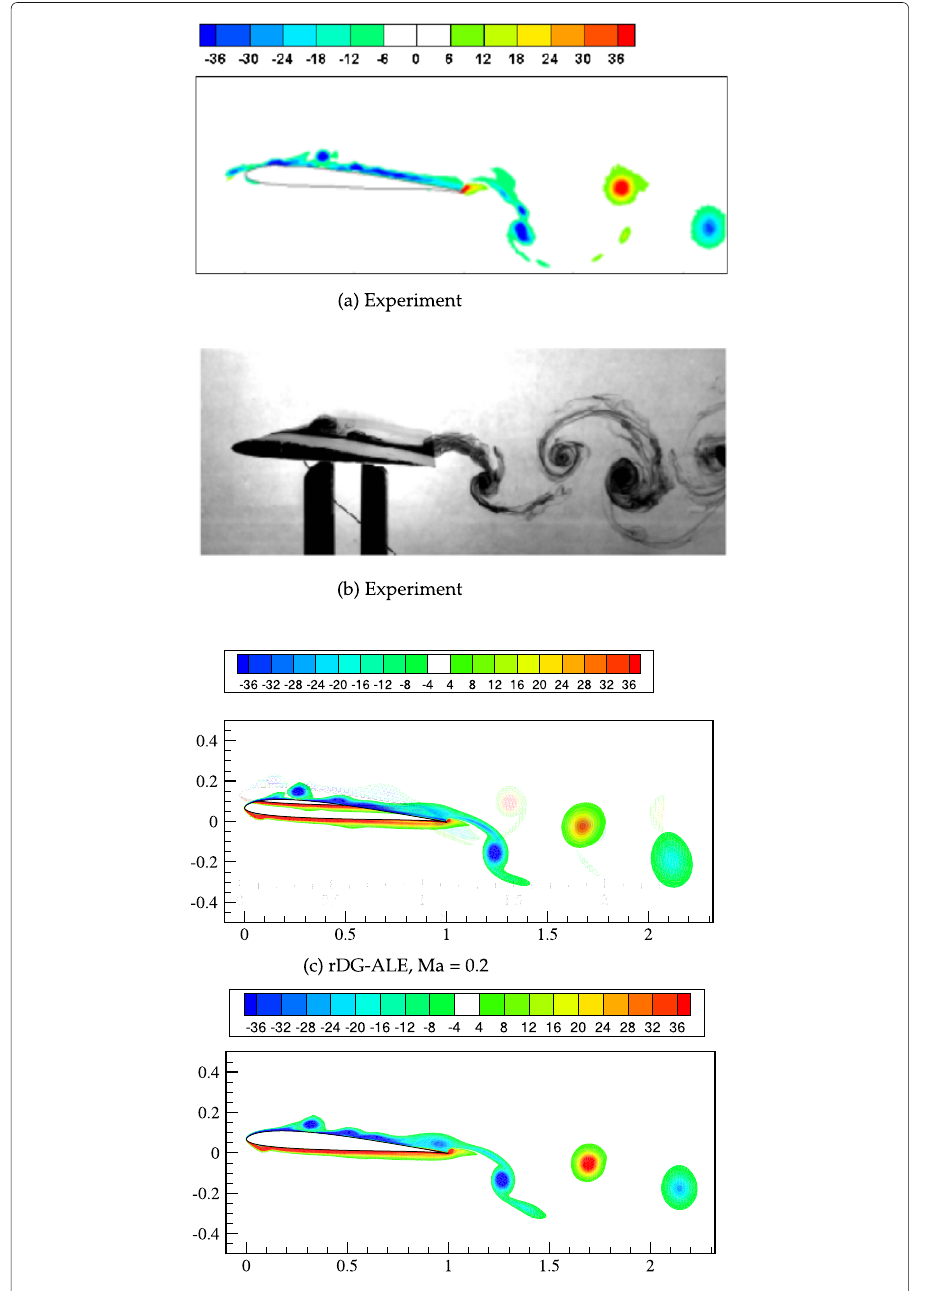
Fig. 18 Comparison of normalized vorticities with experiment at t 1 4 T for the plunging SD7003